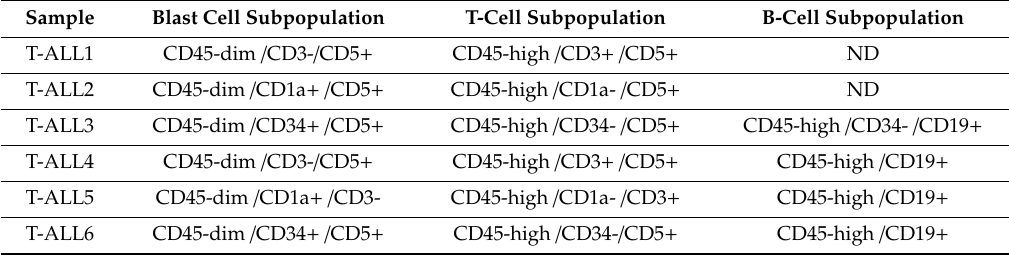
Table A1. The use of specific surface markers to define cell subpopulations in each sample. Sample